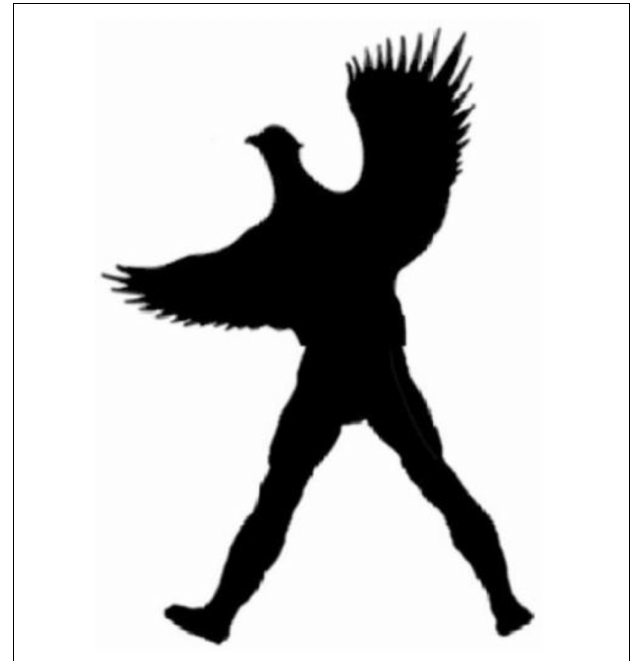
FIGURE 3 | Schematological hybrid: man and